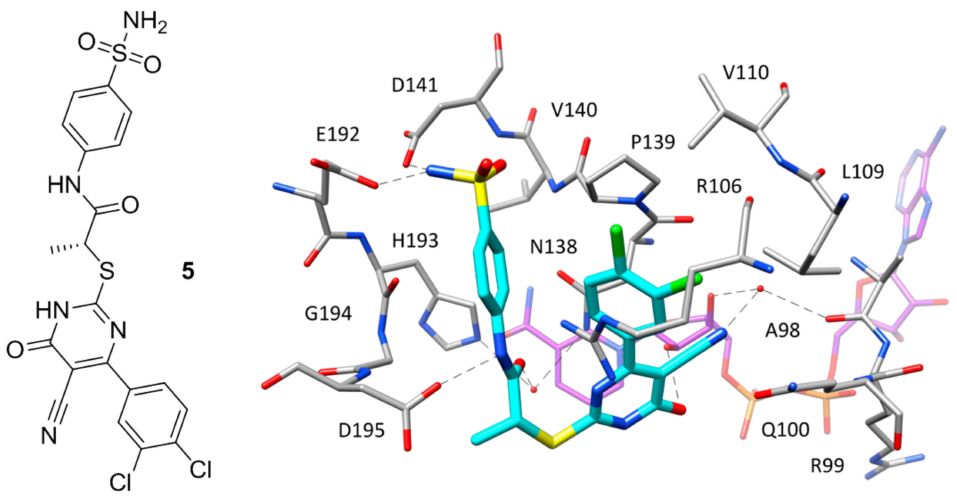
Figure 4. Chemical structure of 5 and X-ray structure of h LDH5 in complex with compound 5 (PDB code 4JNK). The cofactor and active site residues interacting with the inhibitor are shown and the ligand–protein H-bonds are